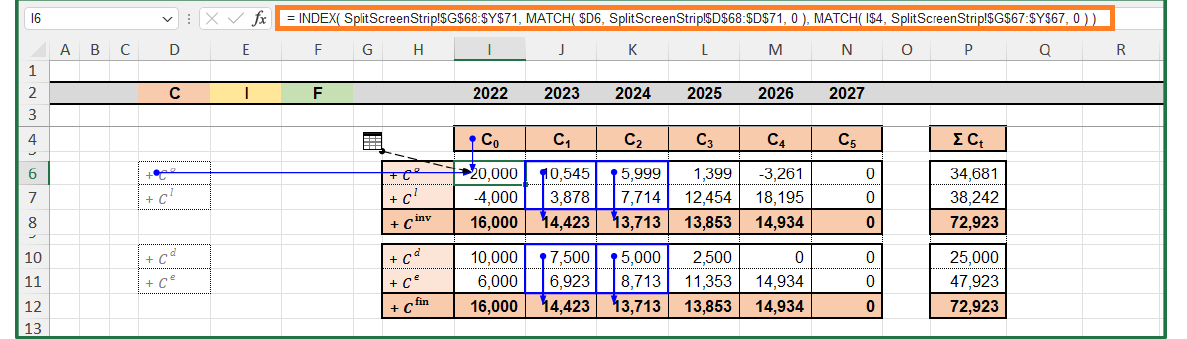
Figure 41. Cell I6 contains the formula for picking up the operating capital 𝐶 (cid:3042) as of period 𝑡 = 0; cells I8:N8 and I12:N12 contain the sums of the two rows above (“TransMatrix” sheet).